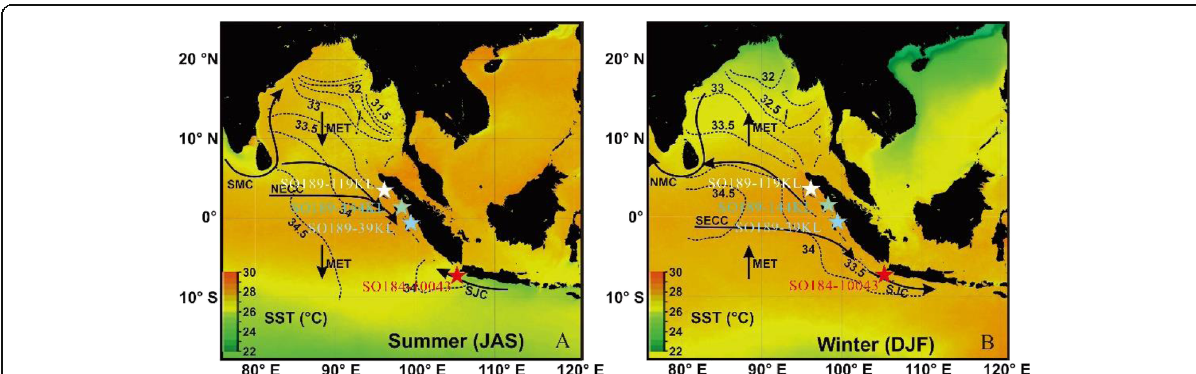
Fig. 1 Location of the sediment core SO184-10043 (red star) with seasonality of surface currents, SST, and salinity in the eastern Indian Ocean (revised from Mohtadi et al. 2014). Seasonal changes in SST (color shading), salinity (dashed lines; psu), and surface currents (arrows) in the study area during boreal summer (top) and winter (bottom). The meridional Ekman transport (ME) is also indicated with arrows. Seasonal SST is averaged for the period between 2002 and 2010 (http://oceancolor.gsfc.nasa.gov/cgi/l3). Salinities are averaged for the period between 1960 and 2004